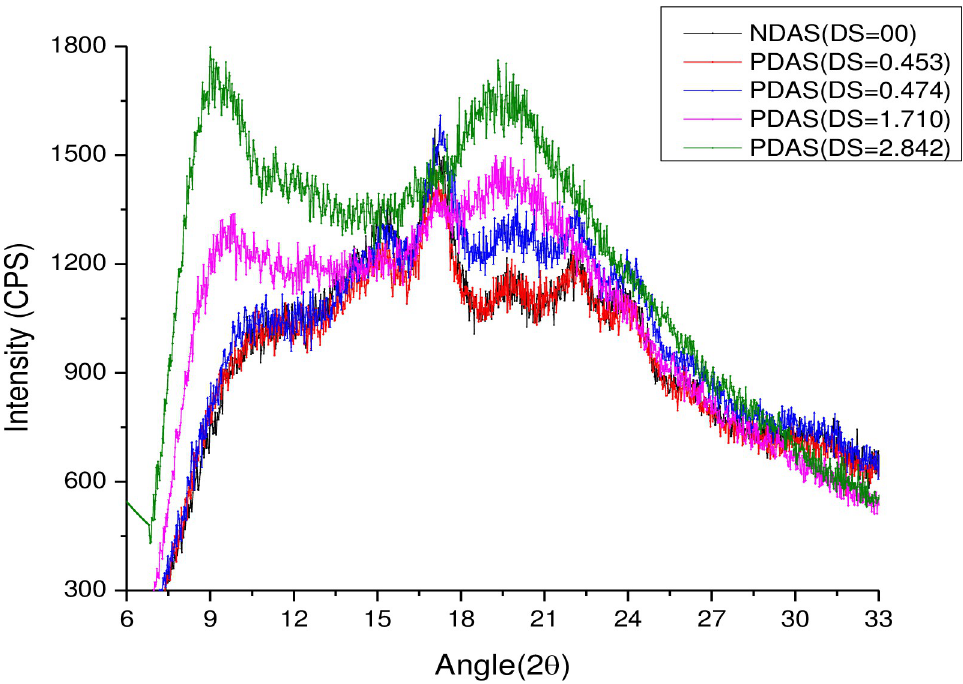
Fig 3. X-ray diffraction patterns of NDAS and PDAS (DS = 0.453, 0.474, 1.710 and 2.842).